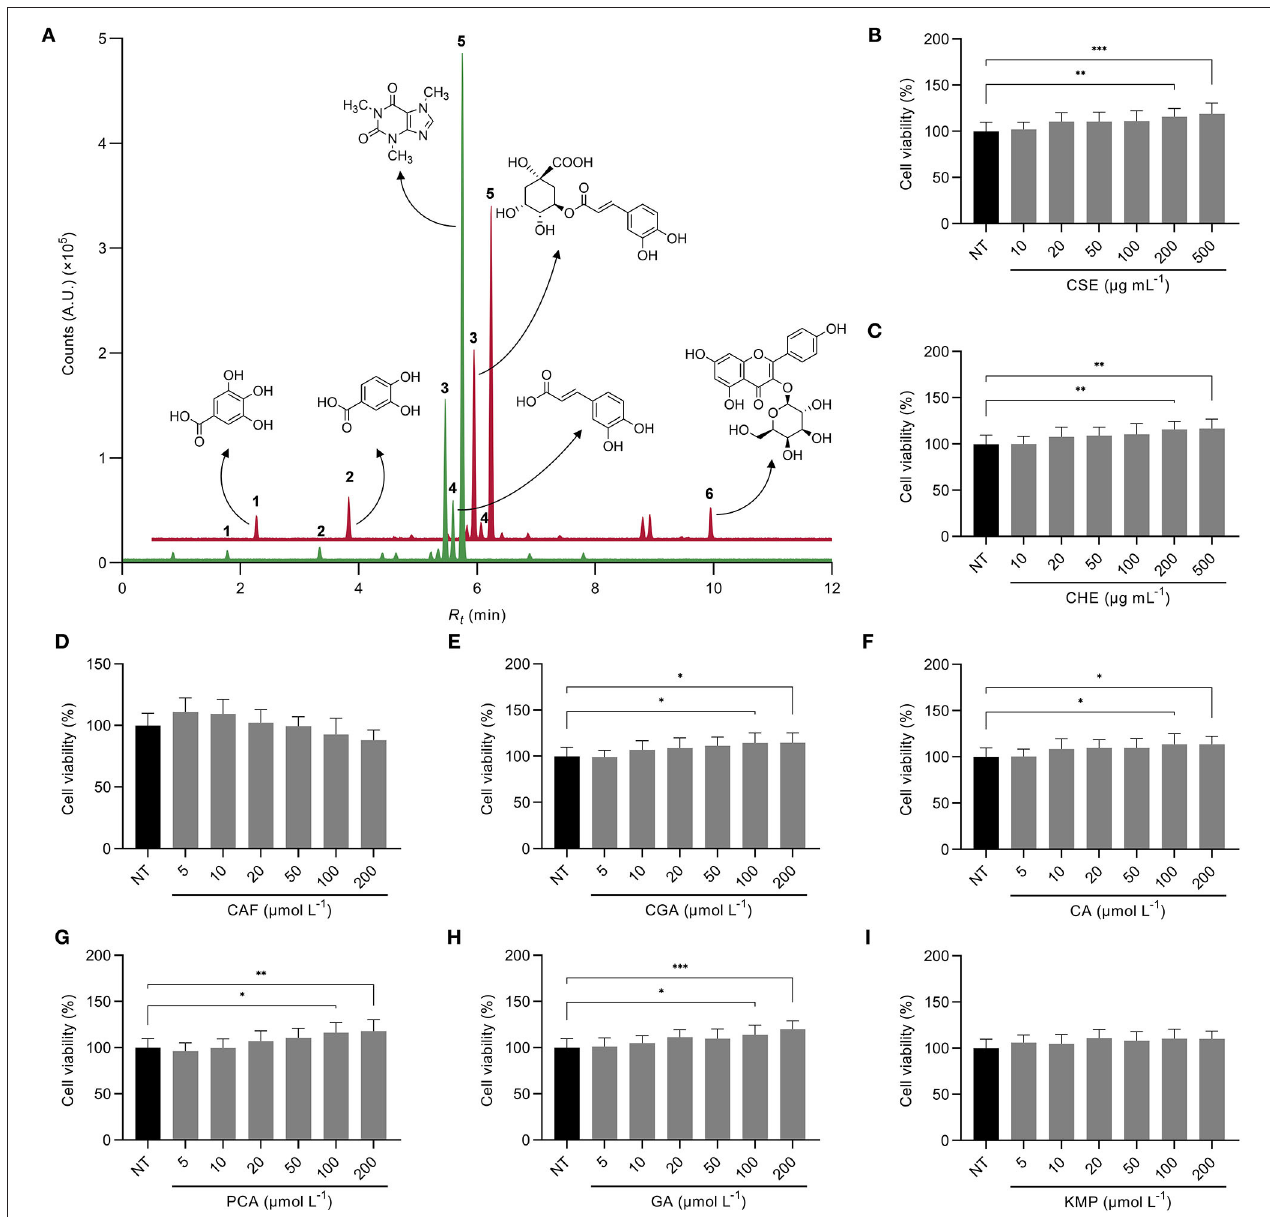
FIGURE 1 | Overlapped UPLC-MS/MS MRM chromatograms of the targeted analysis of bioactive compounds from the coffee silverskin extract (CSE, — red) and the coffee husk extract (CHE, — green) (A) . The most abundant compounds were gallic acid (GA, 1 ), protocatechuic acid (PCA, 2 ), chlorogenic acid (CGA, 3 ), caffeic acid (CA, 4 ), caffeine (CAF, 5 ), and kaempferol-3- O -galactoside (KMP, 6 ). Cell viability of HepG2 cells treated with CSE (B) , CHE (C) , CAF (D) , CGA (E) , CA (F) , PCA (G) , GA (H) , and KMP (I) . The results are expressed as mean ± SD ( n = 3). Asterisks (*, **, or ***) denote significant differences ( p < 0.05, p < 0.01, or p < 0.001, respectively) according to the T- test between the non-treated control (NT) and each of the concentrations of CSE, CHE, and the standard solutions of the bioactive compounds from coffee by-products.